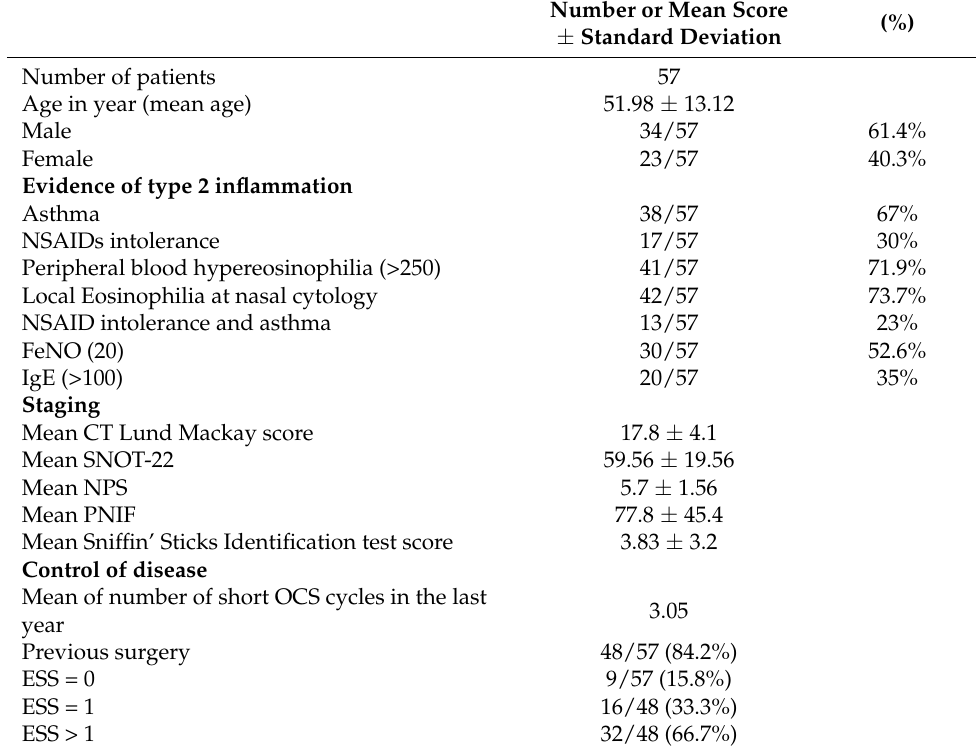
Table 1. Baseline